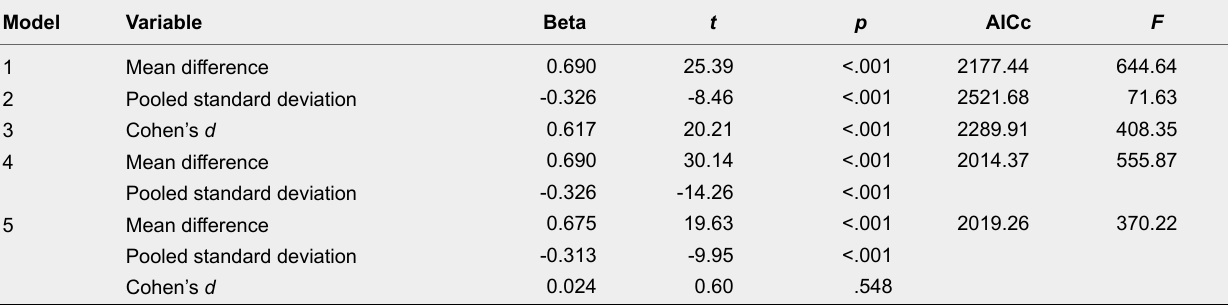
Results of the Generalised Linear Mixed Models on Individual Ratings in Experiment